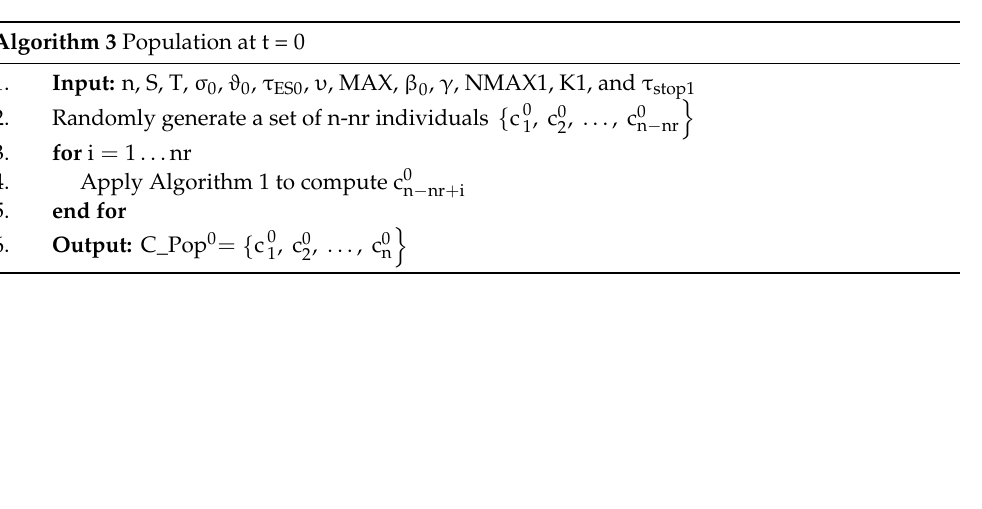
Algorithm 4 parameters: the number of non-effective successive iterations, i.e., without